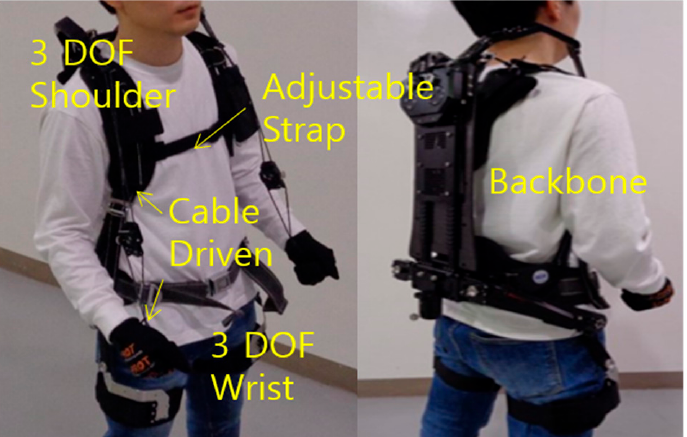
Figure 1. LEXO-W [25]. Reprinted with permission from ref. [25]. Copyright 2021 LIG Nex1.